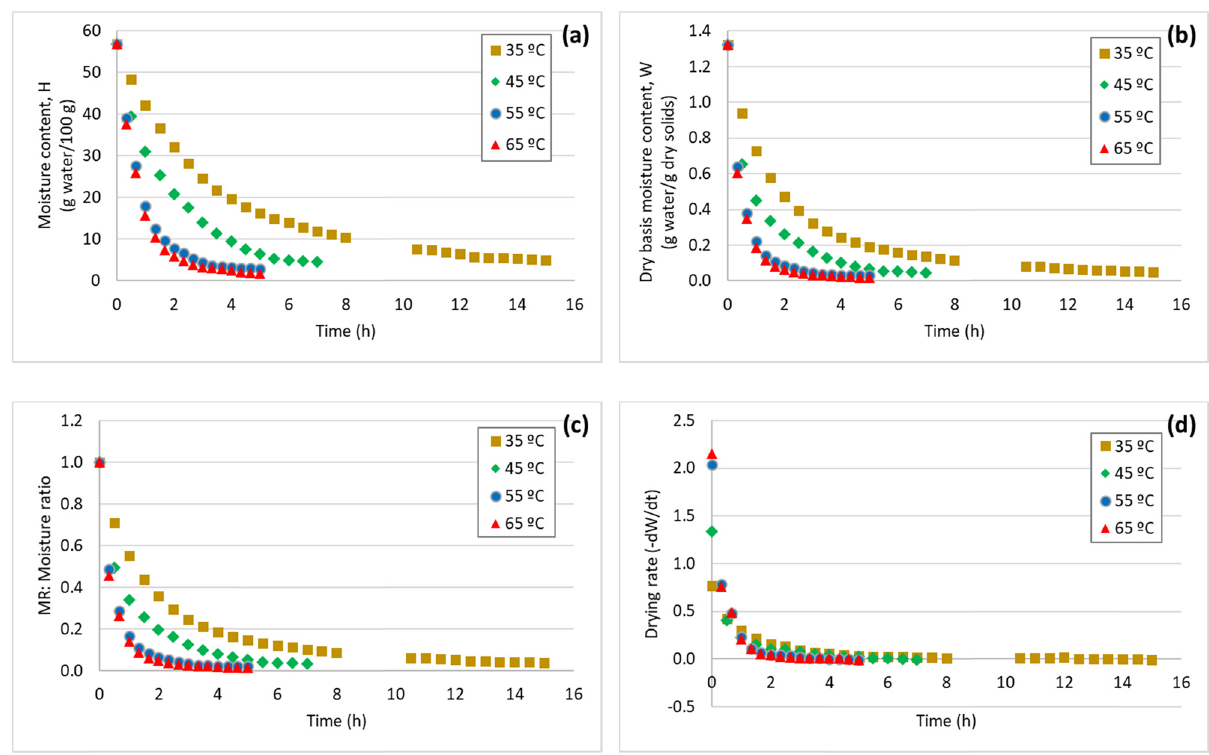
Figure 1: Drying curves for the thistle fl ower: ( a ) wet basis moisture content, ( b ) dry basis moisture content, ( c ) MR and ( d ) drying rate.